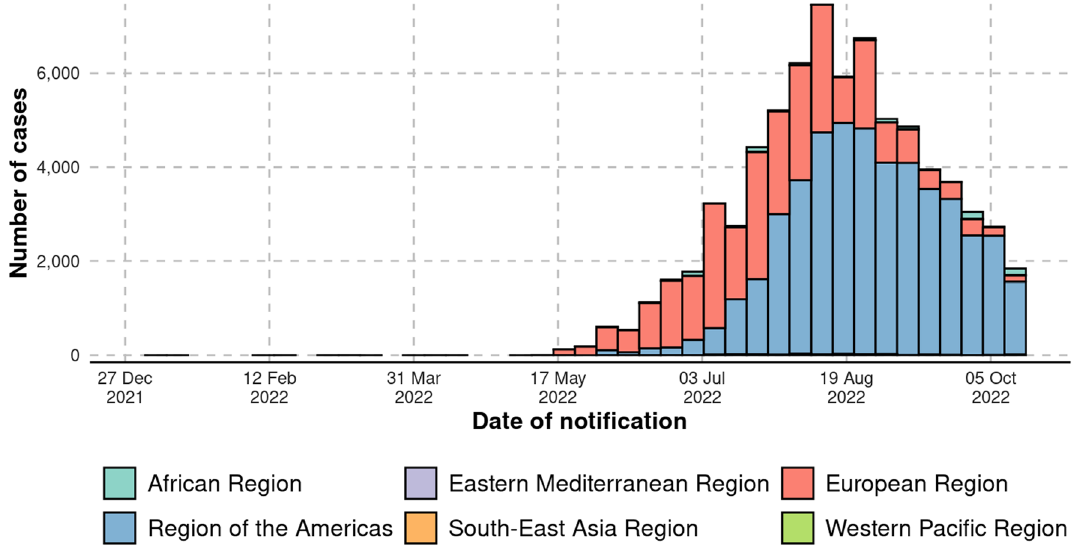
Fig. 1 Trend of monkeypox cases from December 2021 to October 2022 (WHO